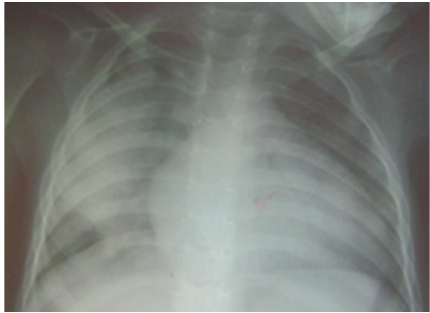
Figure 1: The thorax X-ray shows a cardiomegaly.